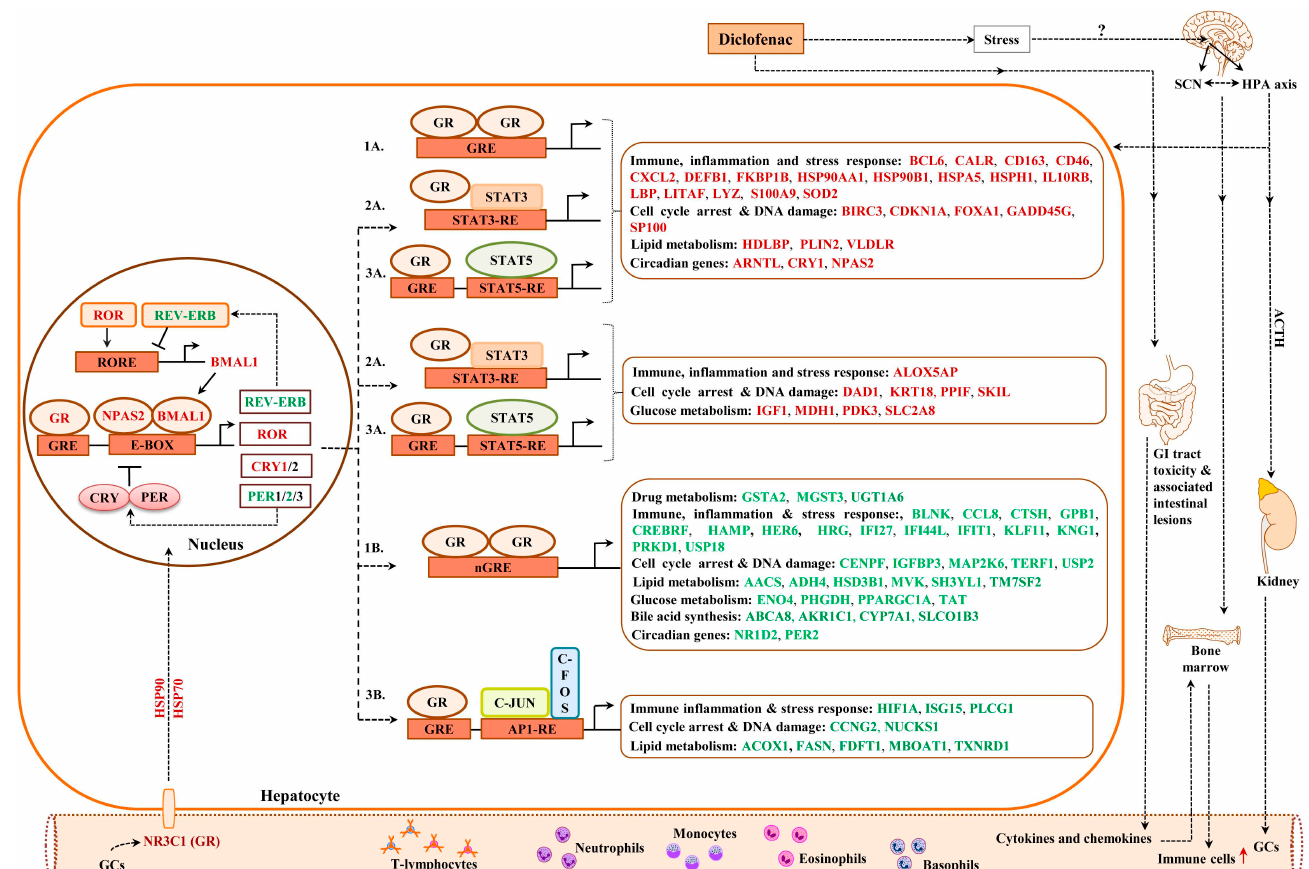
Figure 14. Glucocorticoid receptor targeted genes in response to diclofenac treatment. The glucocorticoid receptor can influence gene expression either through direct or indirect mechanisms. The direct, tethering and/or composite model of GR activity as originally proposed by Oakley and Cidlowski (50) was employed; 1a = direct activation, 1b = direct repression, 2a = tethering model, 3a = indirect or transactivation composite model, 3b = indirect or transrepression composite model.